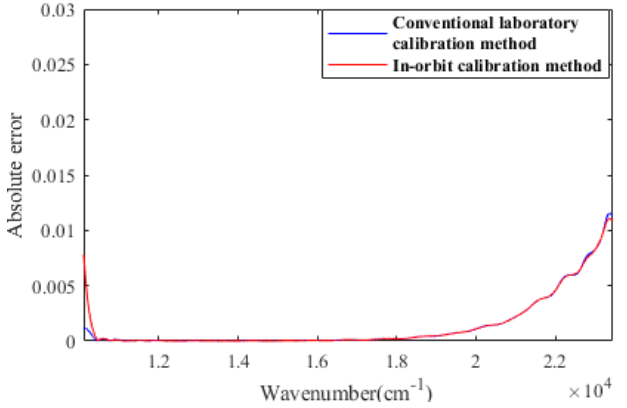
δ δ Figure 4. Calibration errors of δ fore in simulated orbit and in Figure 4. Calibration errors of fore in simulated orbit and in laboratory. Figure 4. Calibration errors of fore in simulated orbit and in laboratory.